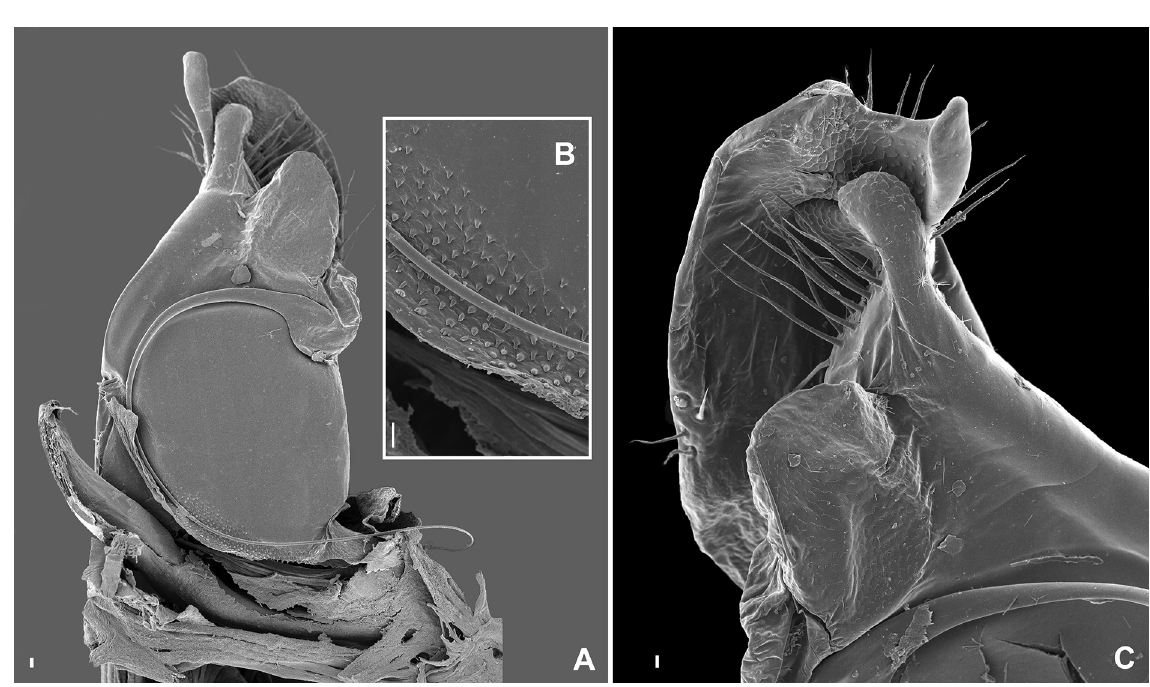
Fig. 11. Cambala annulata (Say, 1821), anterior gonopod. A . Mesal view. B . Detail of the mesal sternal part. C . Apical part of coxal processes and telepodite. Scale bars: A = 100 μm; B–C = 10 μm.